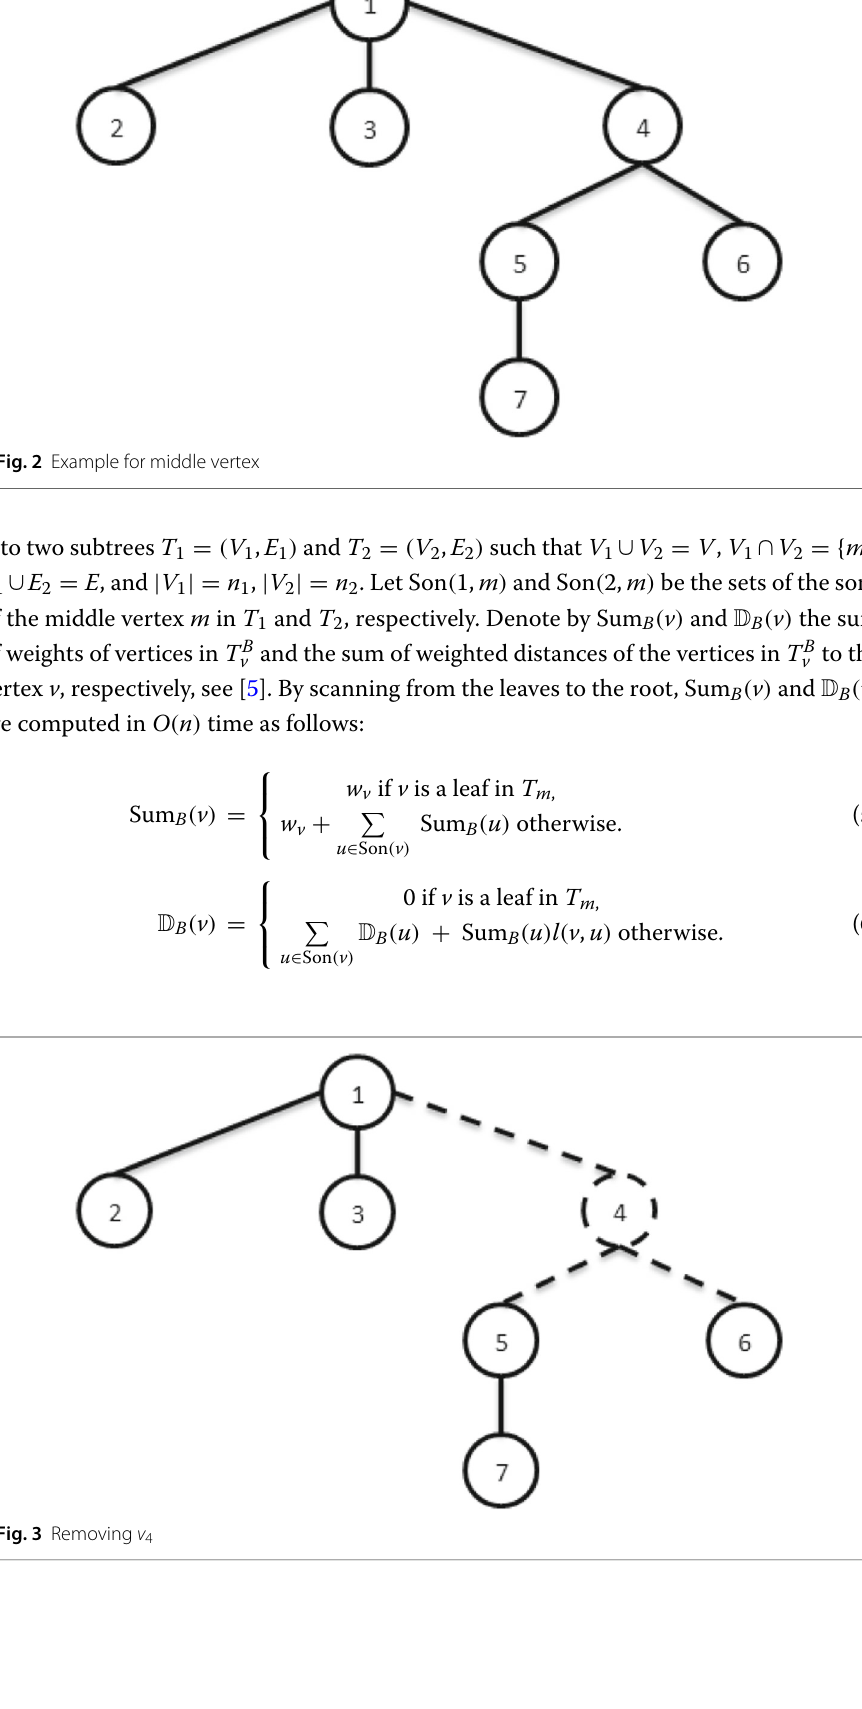
Fig. 3 Removing v